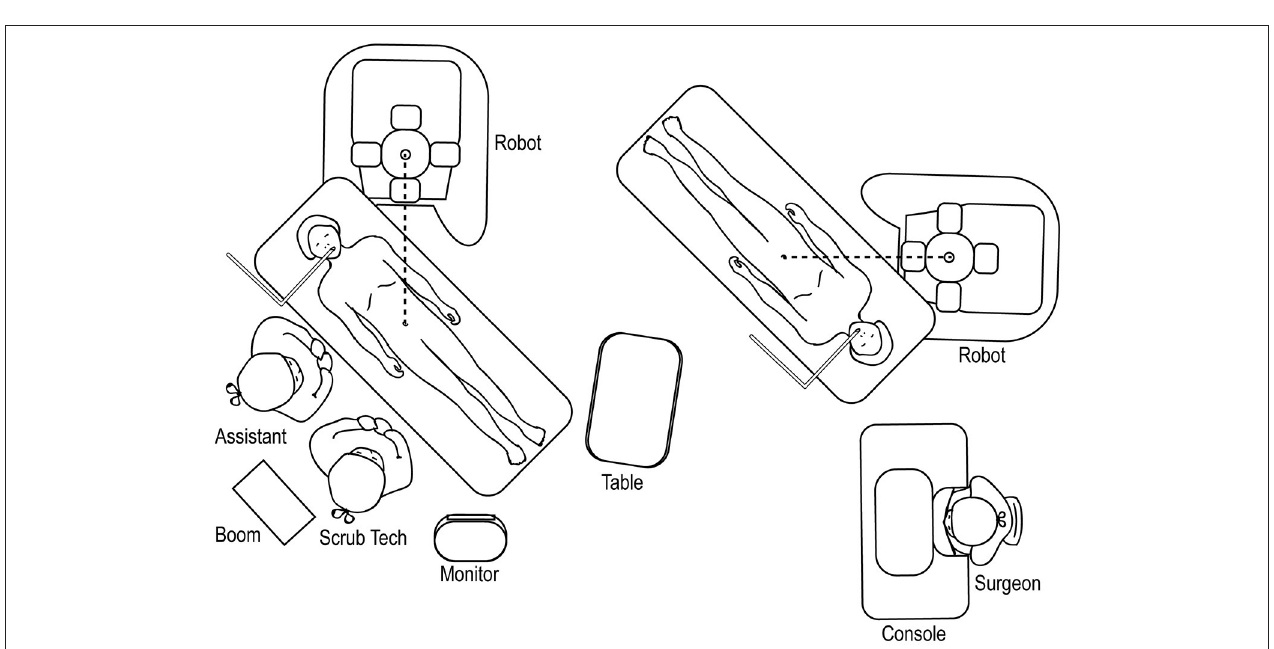
FIGURE 12 | Overhead view of room set-up for upper urinary tract surgery, with robot docked at ipsilateral shoulder.